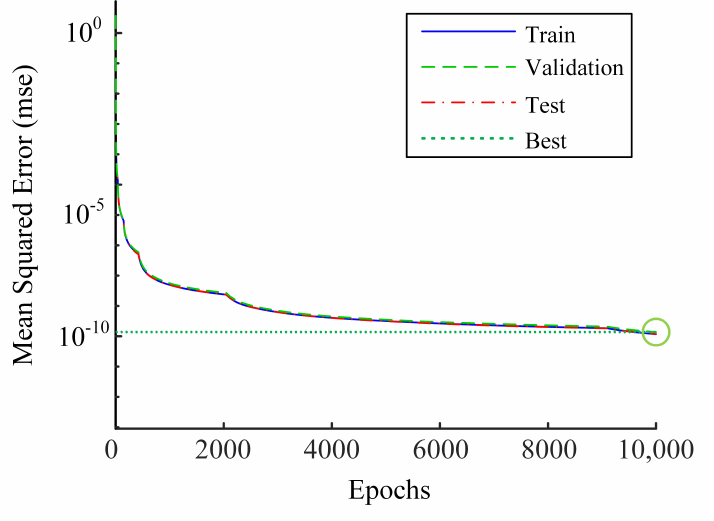
Figure 7. Training performance of the DNN